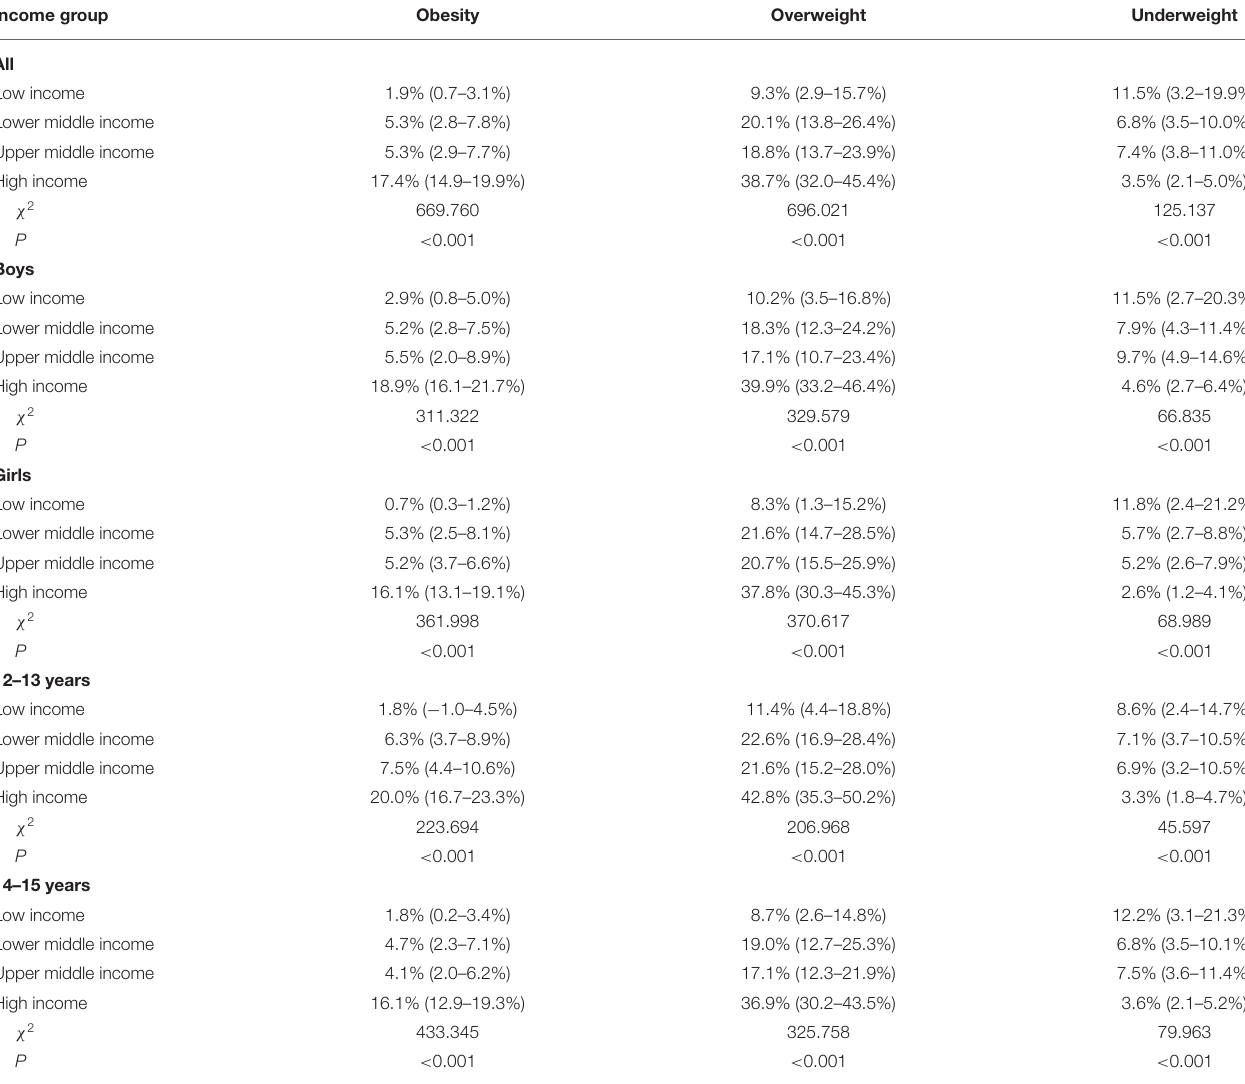
TABLE 3 | Prevalence of obese, overweight and underweight adolescents with hunger by national income, sex and age. Income group Obesity Overweight